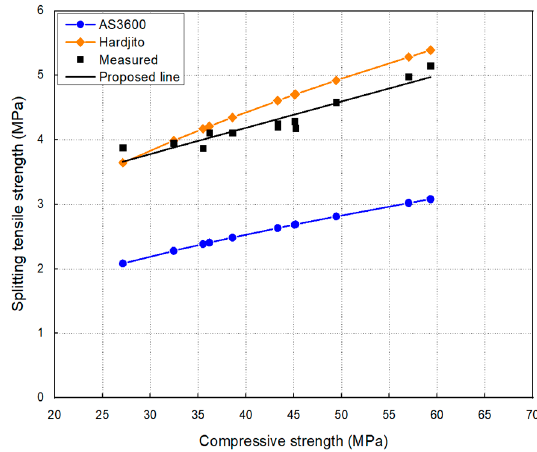
Figure 17. Compressive strength and splitting tensile strength relationship.